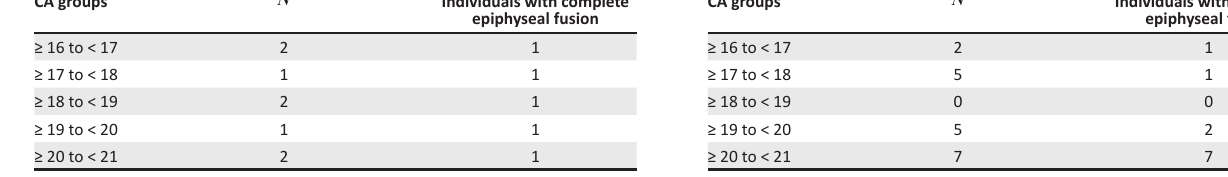
TABLE 4: The number and percentage of skeletally mature female patients per chronological age group. CA